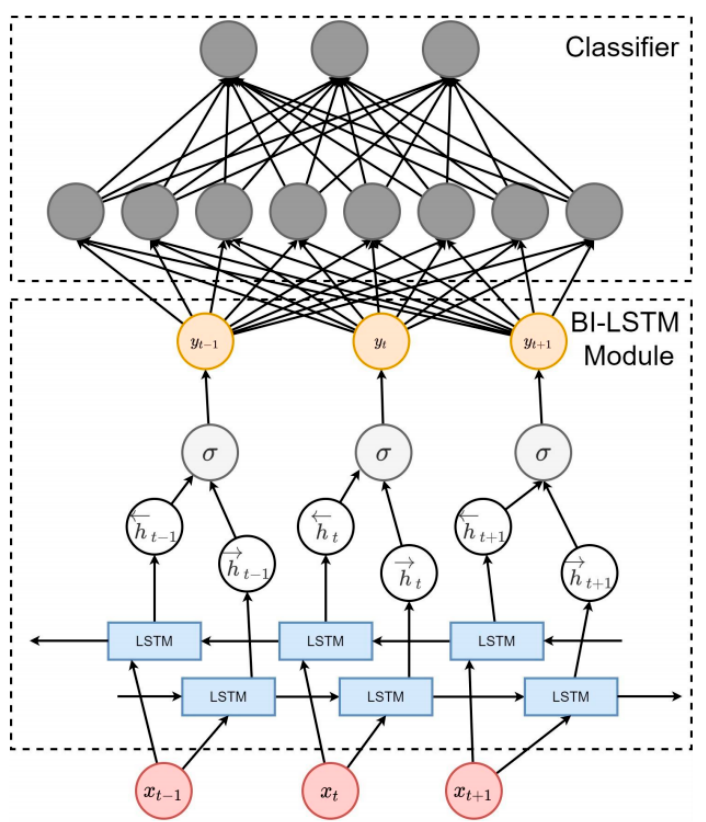
Figure 4. The BI-LSTM and the classifier.